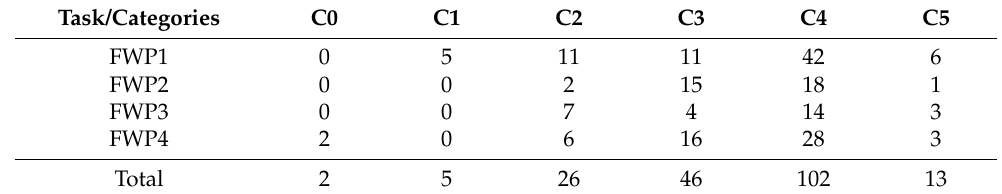
Table 5. Distribution of the number of participants’ written answers according to task types and